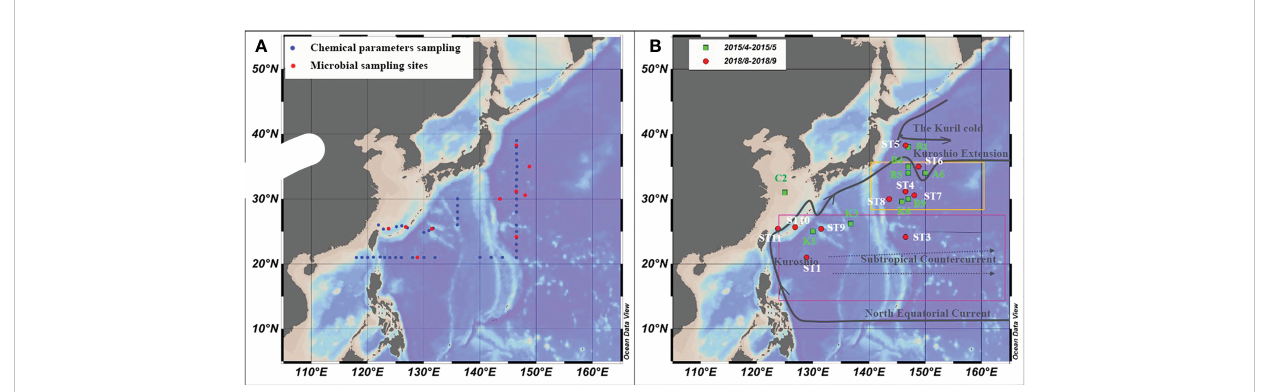
FIGURE 1 Microbial sampling sites and ocean currents in the study area. (A) Chemical parameter (blue) and microbial samples sampling stations in the NWPO from August to September 2018; (B) The microbial sampling stations in April-May 2015(green dots) and in August-September 2018 (red dots), and ocean current